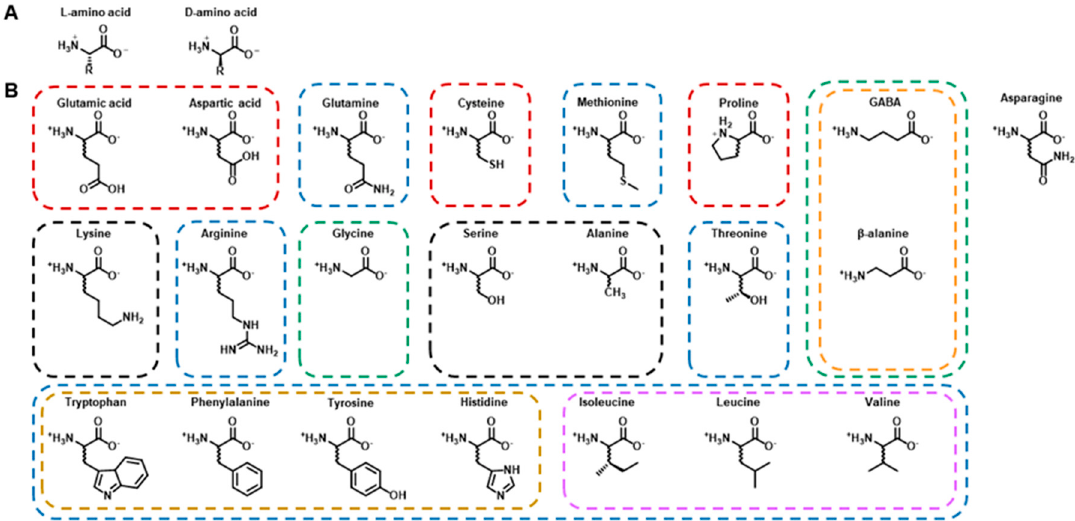
Figure 1. Stereochemistry of amino acids and their side chains. ( A ) Stereoisomers of amino acids are classified as D or L. The amino acids in proteins are the L stereoisomers according to the D / L system and are in the S configuration of the R / S system (except for cysteine which is actually in the R configuration due to the presence of a sulfur atom in the side chain and naming conventions). Unless stated otherwise, amino acids referred to in this review should be assumed to be the L stereoisomer. ( B ) The 22 amino acids reviewed in this paper with boxes classifying them based on their main functions. Non-proteinogenic amino acids are indicated by an orange box. The red boxes denote excitatory amino acids, while the ones in green boxes are inhibitory. Amino acids in blue boxes serve primarily as precursors for neurotransmitters, and the ones in black boxes have neuromodulatory e ff ects. The aromatic amino acids are grouped together in a yellow box, while the branched-chain amino acids (BCAAs) are grouped in a purple